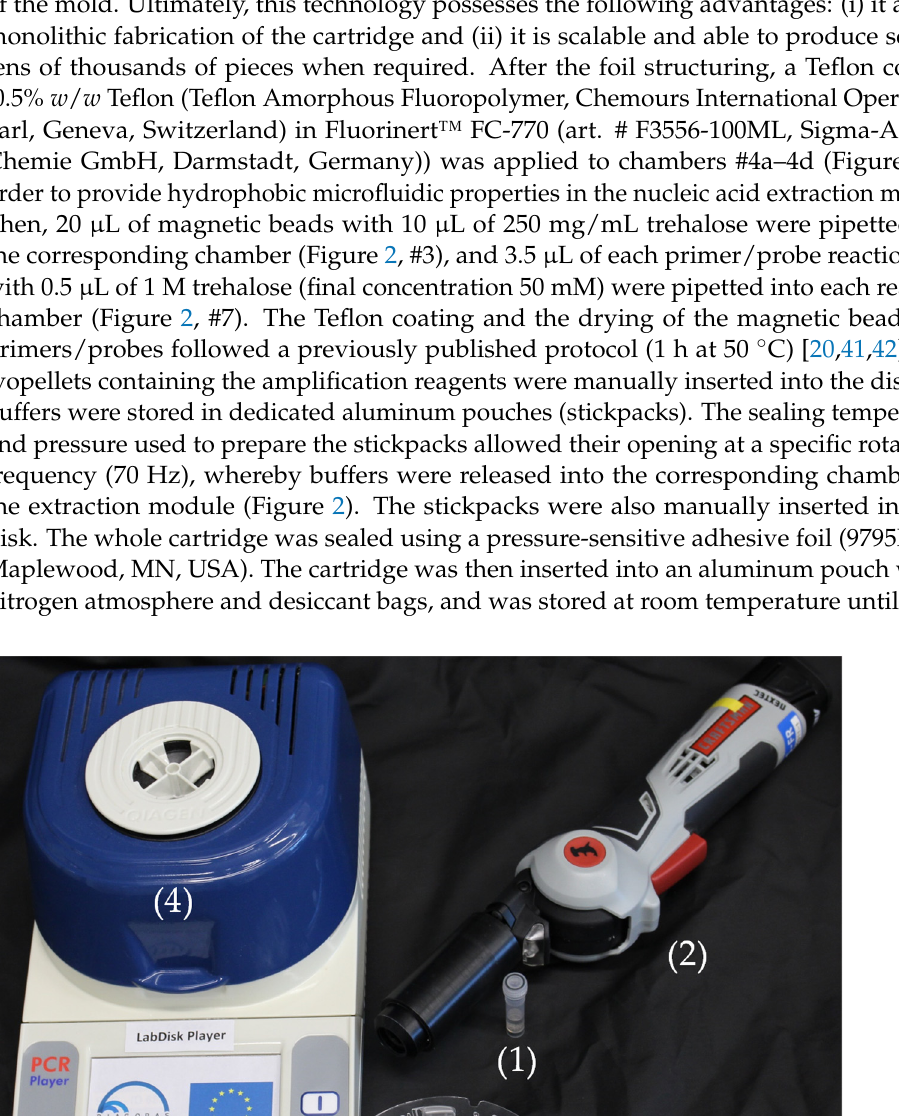
Figure 3. Image of the items which comprise the experimental setup. ( 1 ) Tube containing the mixture of the saliva sample, S. marinus control bacterium and steel beads. ( 2 ) Hand-held device (Terralyzer), into which the tube is inserted for performing the mechanical lysis and saliva homogenization. ( 3 )